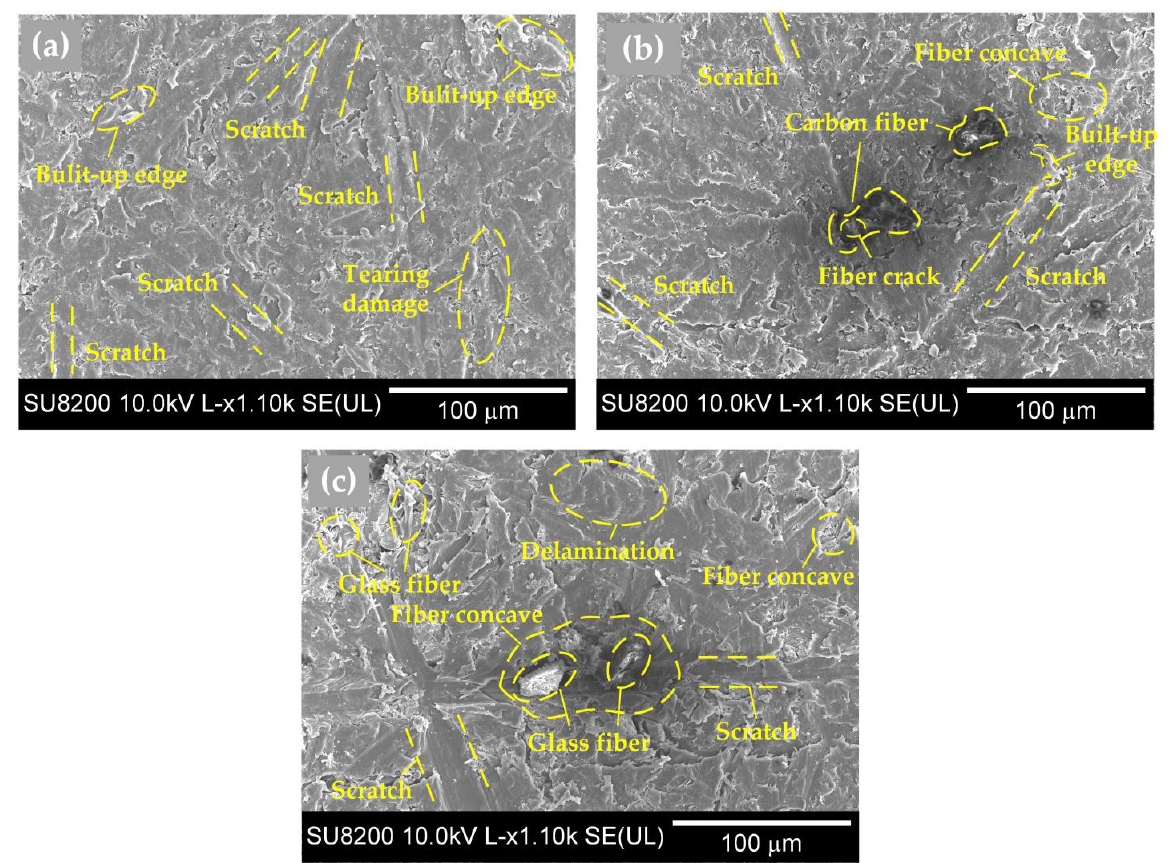
Figure 8. Surface morphology lapped with the #1000 mesh size silicon carbide abrasive paper of various fiber types of reinforced PEEK materials, ( a ) pure PEEK; ( b ) carbon-fiber-reinforced PEEK with the 30% fiber mass fraction; ( c ) glass-fiber-reinforced PEEK with the 30% fiber mass